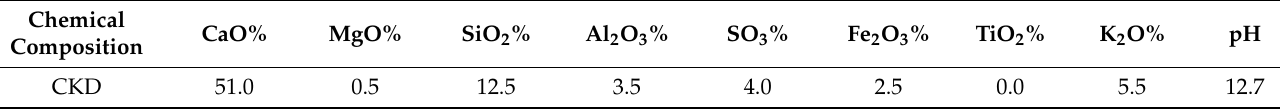
Table 3. CKD—chemical composition and